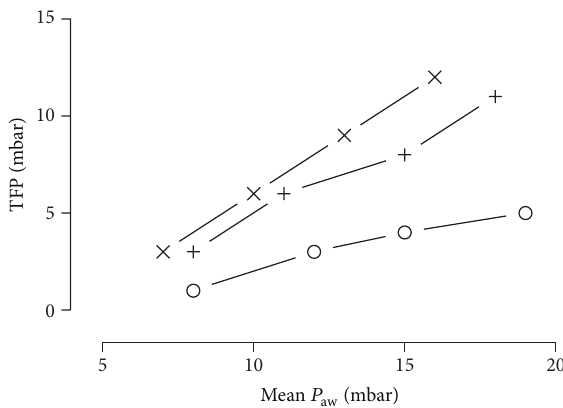
Figure 4: Transfenestration pressures of Portex Blue Line Ultra (+), TRACOE twist ( × ), or R¨usch Traceofix ( I ) tracheostomy tubes plotted against increase in mean airway pressures. Measurements were obtained in volume-controlled ventilation (ventilator rate: 15 breaths ⋅ min −1 , tidal volume: 450 mL) at 37 ± 1 ∘ C. Lung simulator compliance: 20 mL ⋅ mbar −1 . TFP: transfenestration pressure; 𝑃 aw : mean airway pressure.